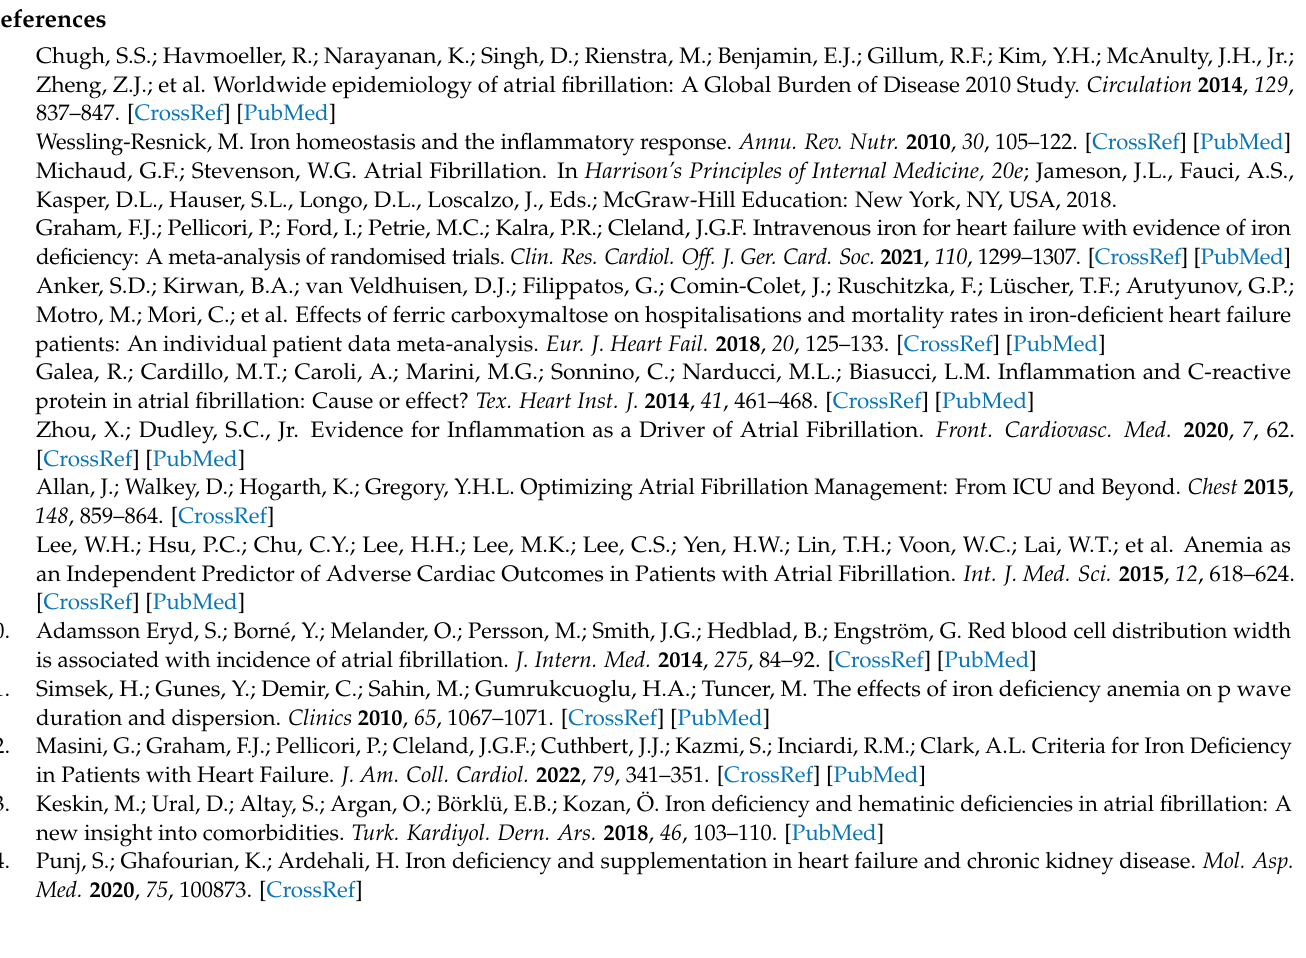
Table S3. Distribution of Chronic Kidney Disease based on KDIGO